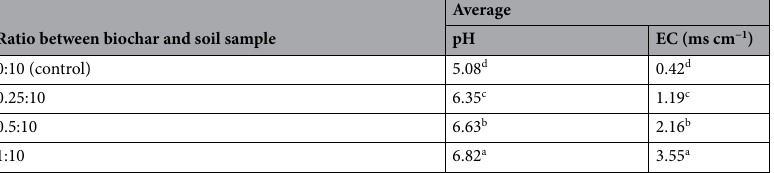
Ratio between biochar and soil sample